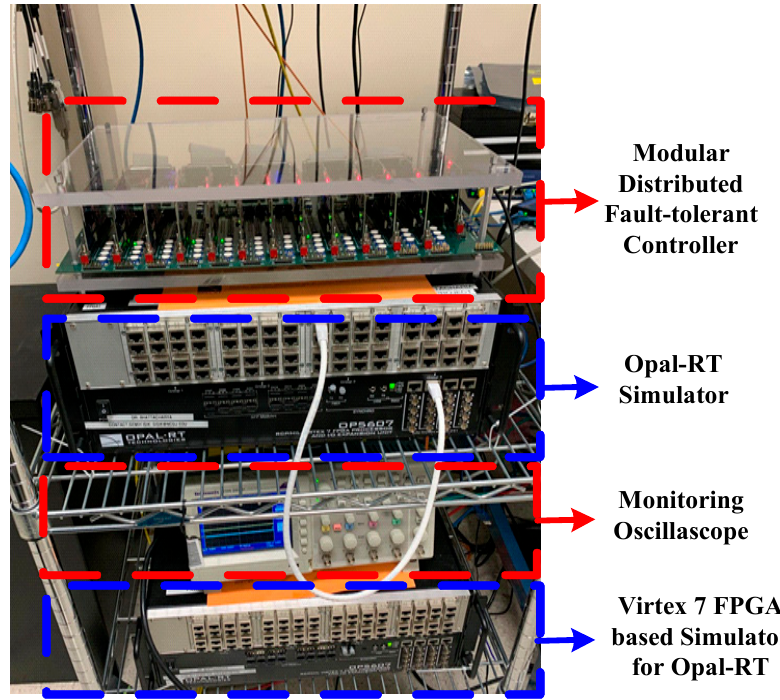
Figure 20. Opal RT and the controller HIL setup.